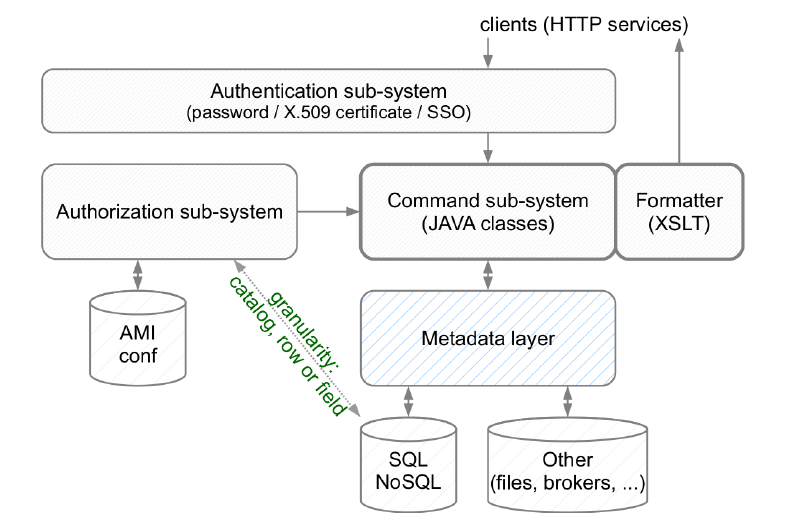
Fig. 3. Overview of the “metadata” layer with: the connection pool; the transaction pool; the reflection sub-system; the Metadata Query Language (MQL) and the “data primitives”